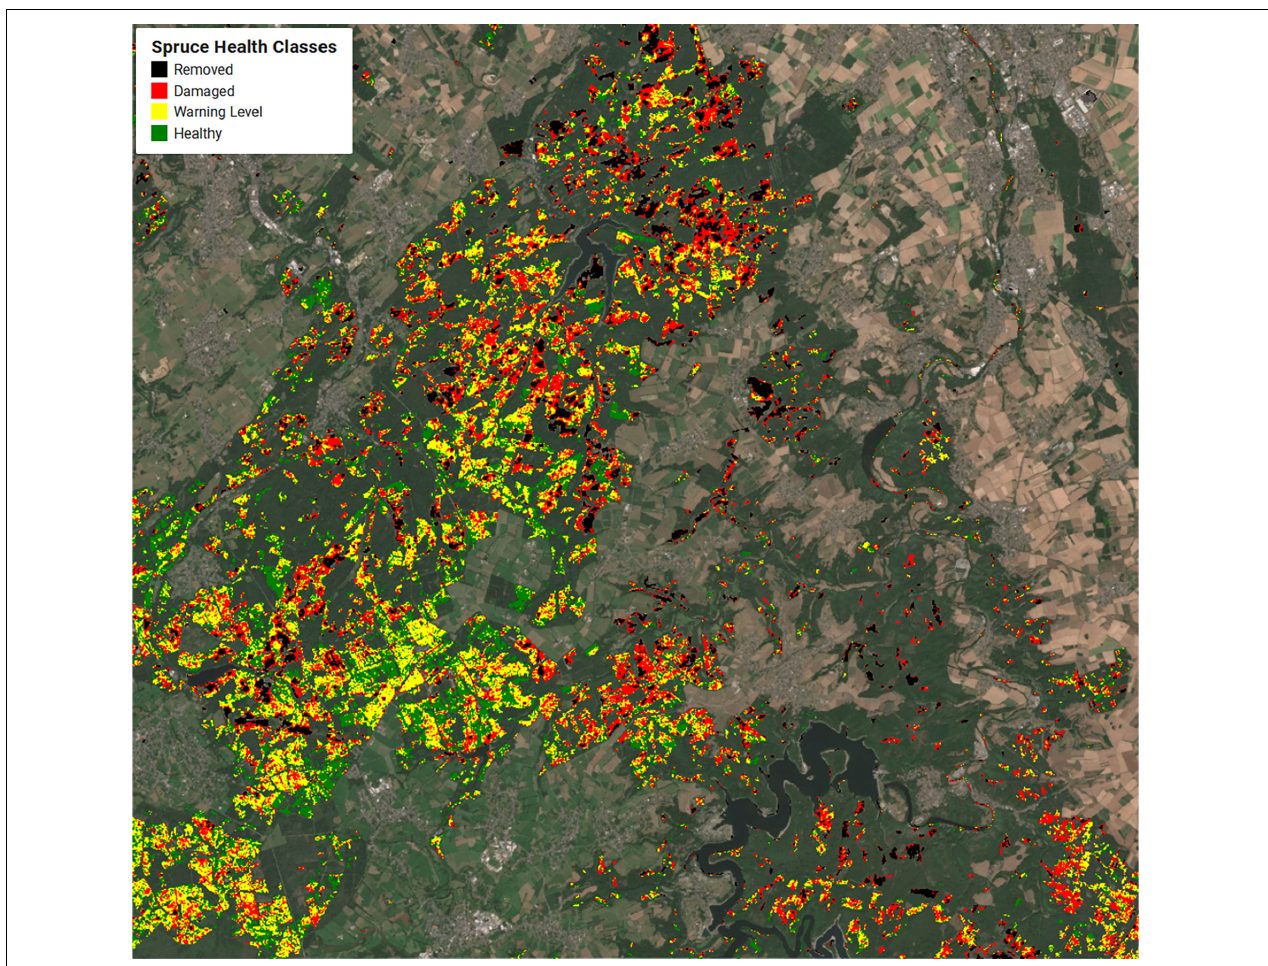
FIGURE 7 | 2020 spruce health classes removed (black), damaged (red), warning level (yellow), and healthy (green) estimated by this study in respect to the CDF matched Sentinel-2 median composite of 2020. The region of interest covers an area of 533 km 2 .